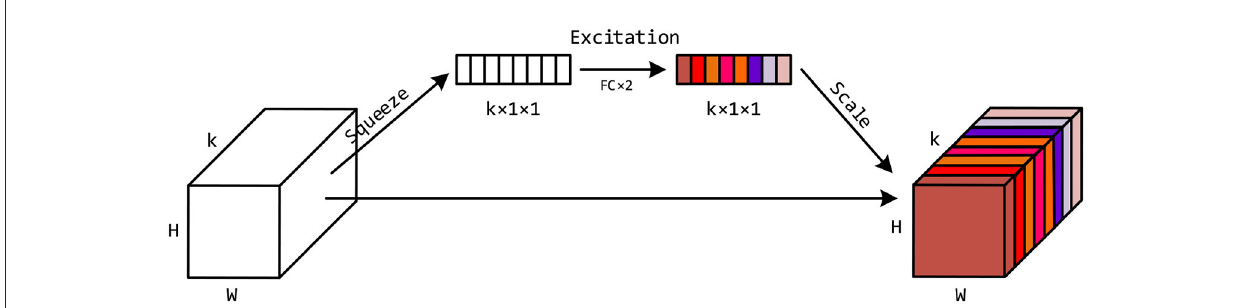
FIGURE3 The architecture of the Timely-Squeeze-and-Excitation (TSE) layer. The squeeze stage uses global pooling to transform the input tensor with shape k × H × W into a vector with length k . The excitation stage uses two fully-connected layers to transform the k entries in the vector into values between 0 and 1. The scale stage uses these k values as importance weights to multiply with corresponding feature matrices in the input tensor to TSE.